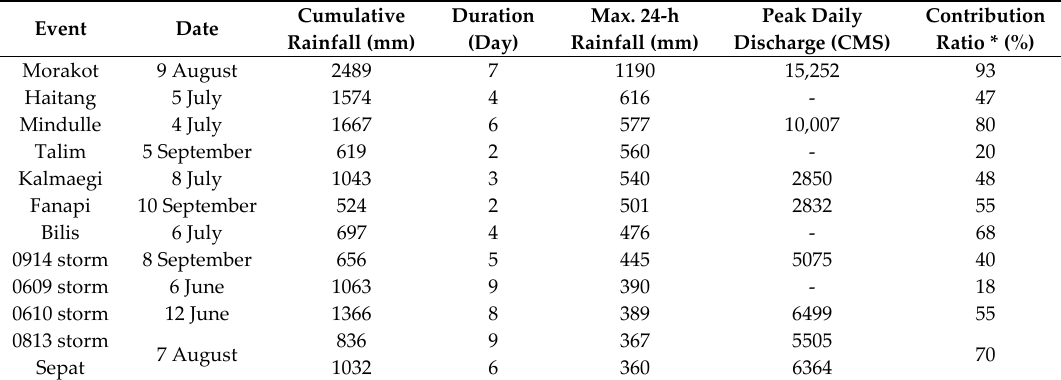
Table 4. Summary of the rainfall characteristics, observed peak daily flow and sediment contribution ratio for the top 12 major rainfall events (ranked by the maximum 24-h rainfall) in GRB during 2004–2012.